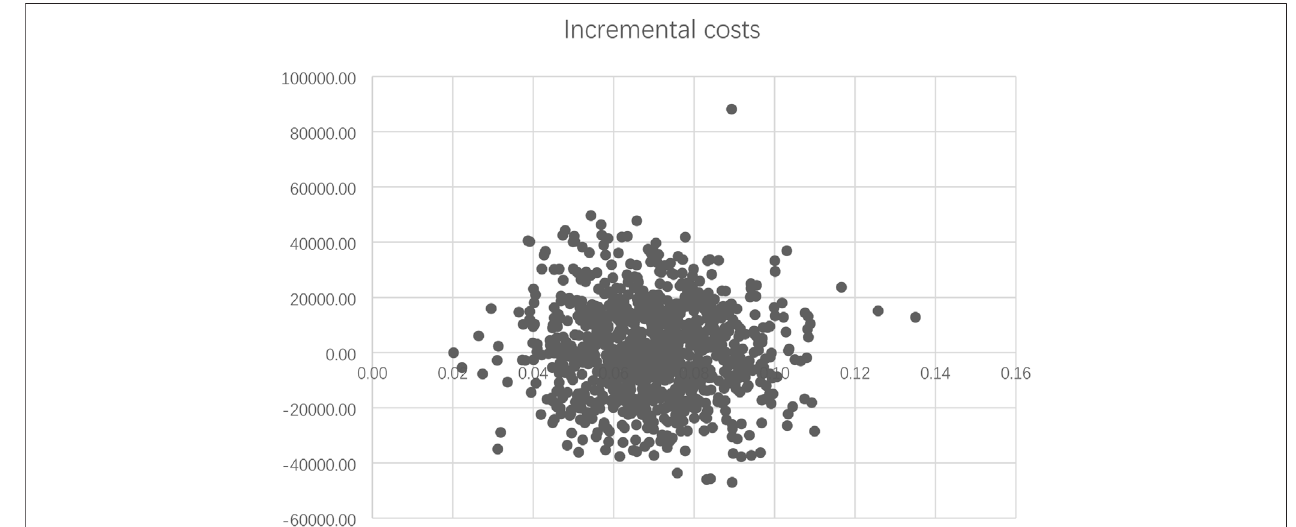
FIGURE 3 | Cost effectiveness plane for PEG-rhg-CSF compared to